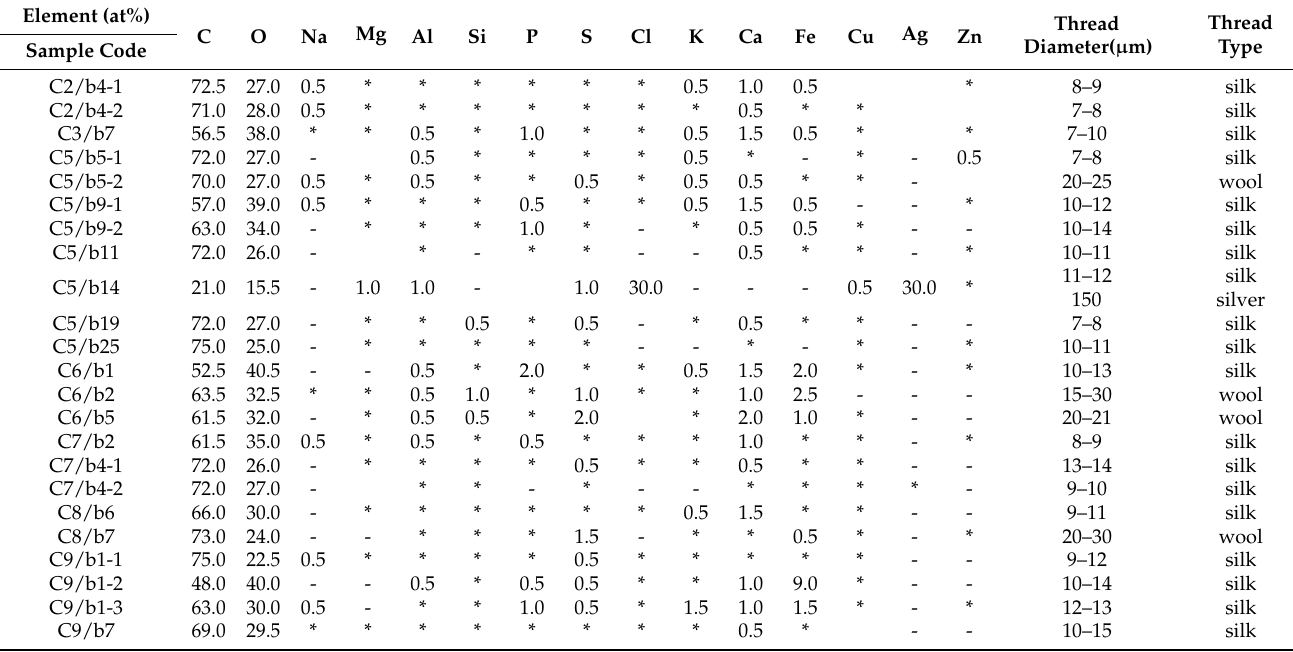
Table 1. Composition of elements (in atomic %) based on EDS